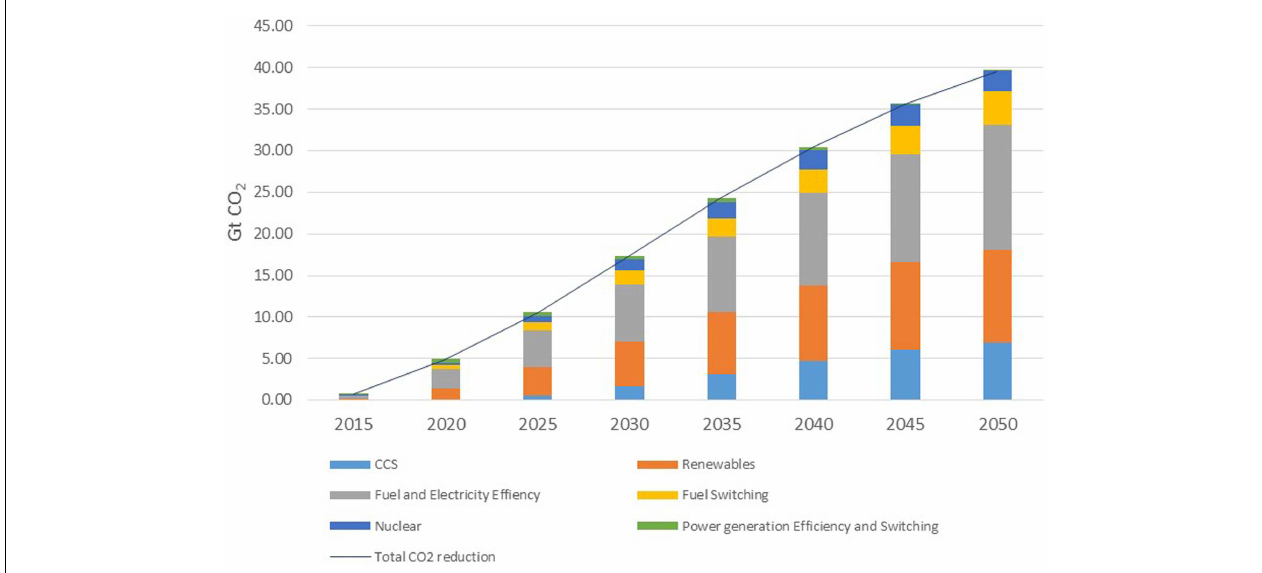
FIGURE 1 |World CO 2 reduction targets to meet the 2°C scenario (2DS) adapted from IEA EnergyTechnology Perspectives (2014) .